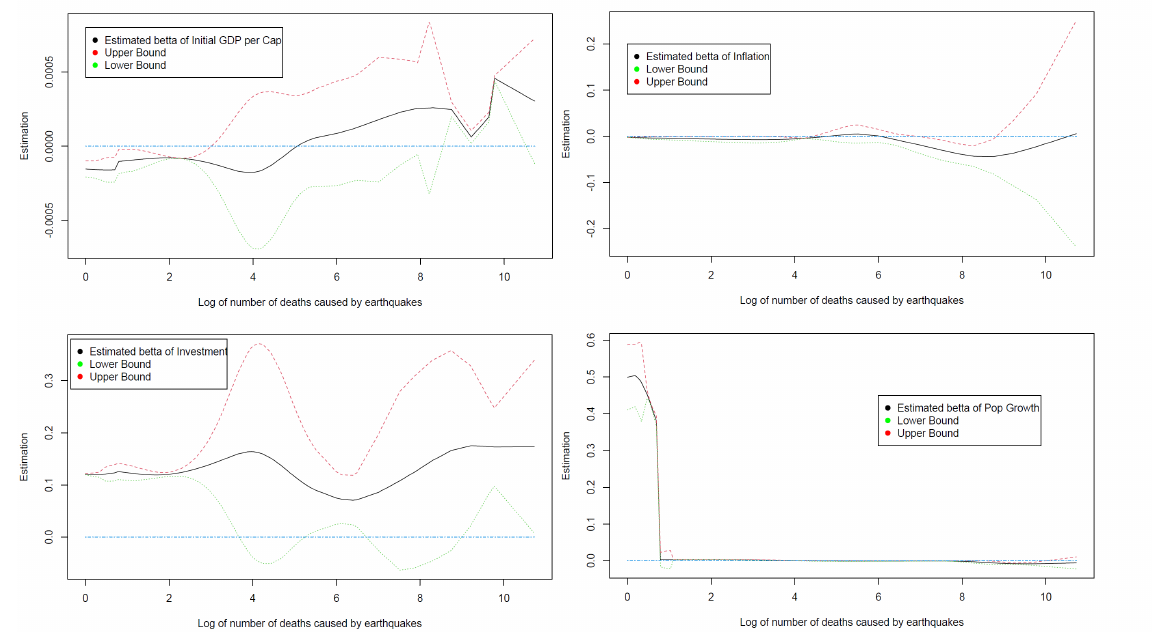
Figure 1. Smooth coefficient with fixed effects model using earthquake